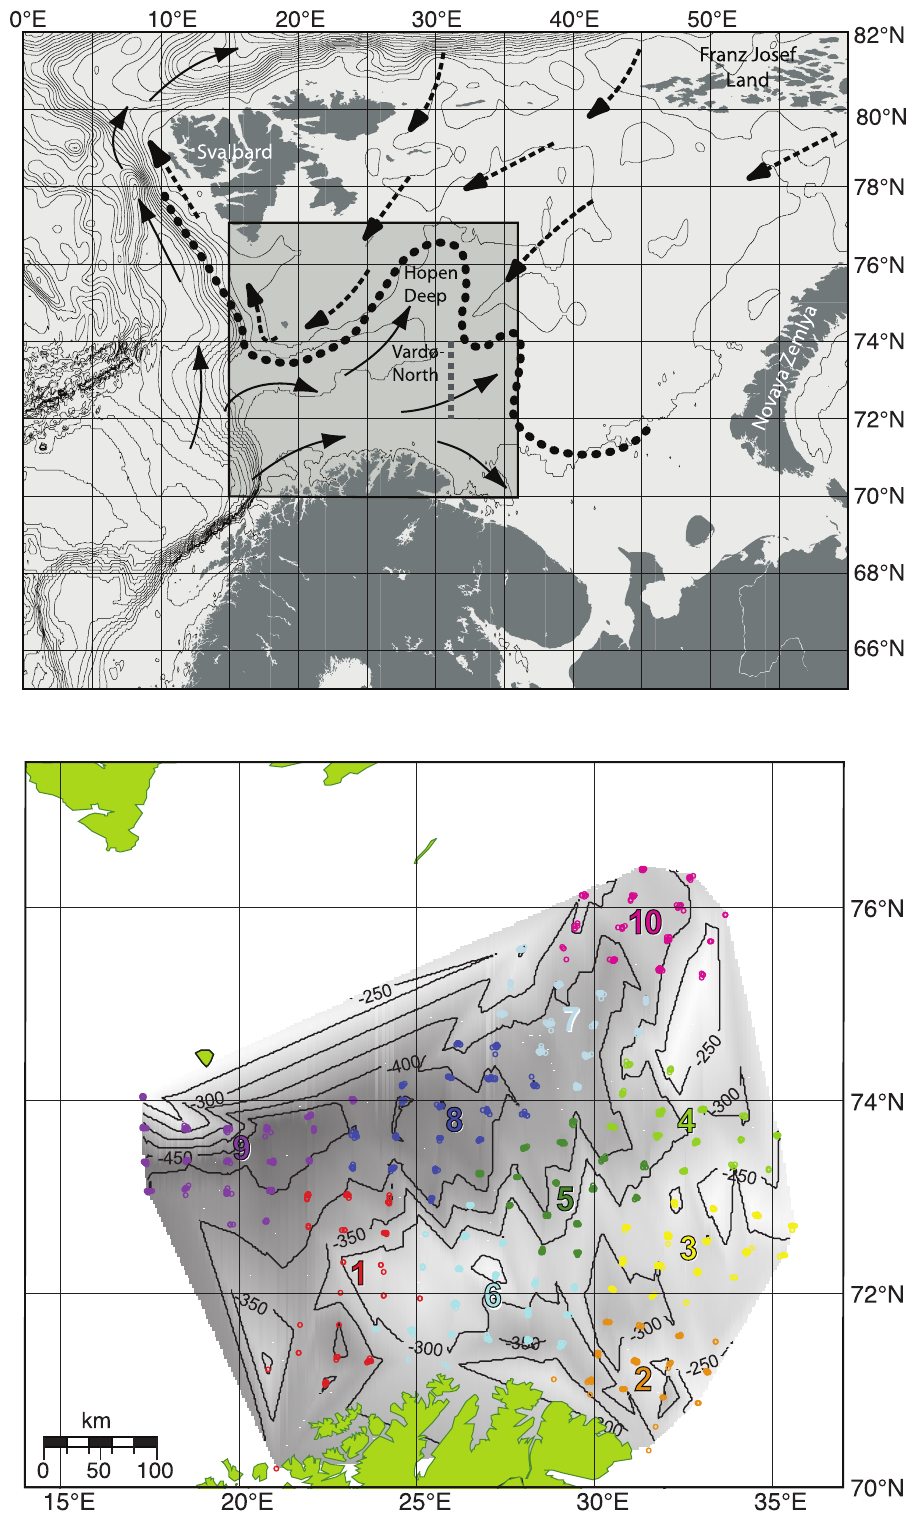
Figure 1. Main surface currents, bathymetry and sampling regions in the Barents Sea. ( a ) Atlantic currents ( – . ) and Arctic currents ( – . ) and the mean position of where these water masses meet, at the depth of 20–100 m, the Polar Front ( N N N ) that most years follows the 200 m depth isoline that limits the study area in the North. The Vardø-North section located at 31 u 13 9 E. The study area is indicated by the grey square. In ( b ) bathymetry (shaded with isolines) based on information from all stations in 1992 2 2004 and stations (dots) with color of region (R1–R10). Stations shallower than 200 m have been excluded in all years.